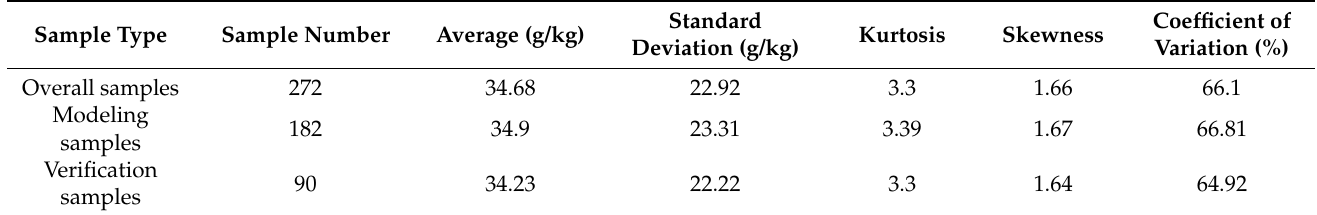
Table 3. SOC content statistic of modeling sets and verification